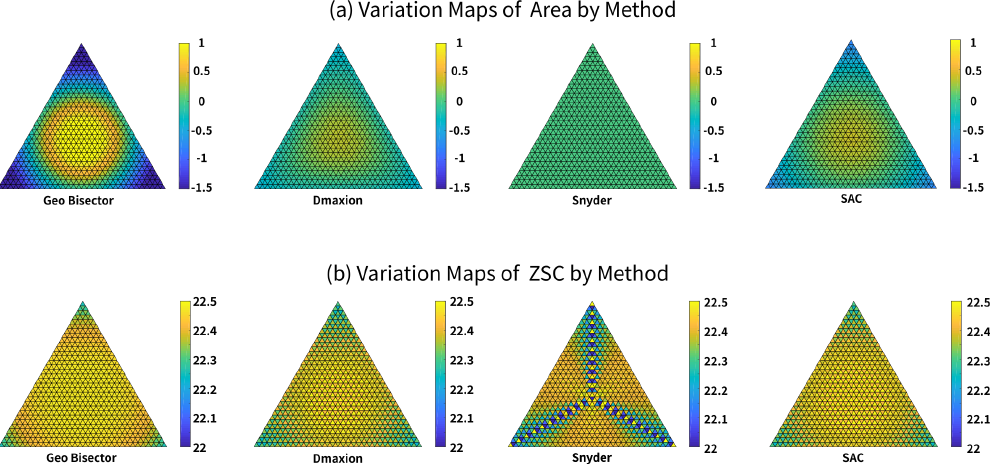
Figure 24. Maps of the spatial variation in the area and ZSC measurements for the Geo Bisector, Snyder, Dymaxion, and SAC methods for the tetrahedron and 4-fold density ratio.